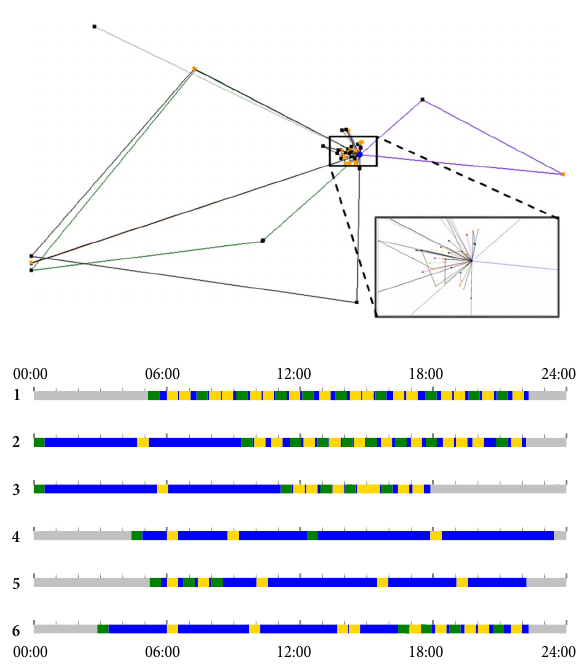
Fig. 6. Vehicle routing and scheduling solutions for a sample